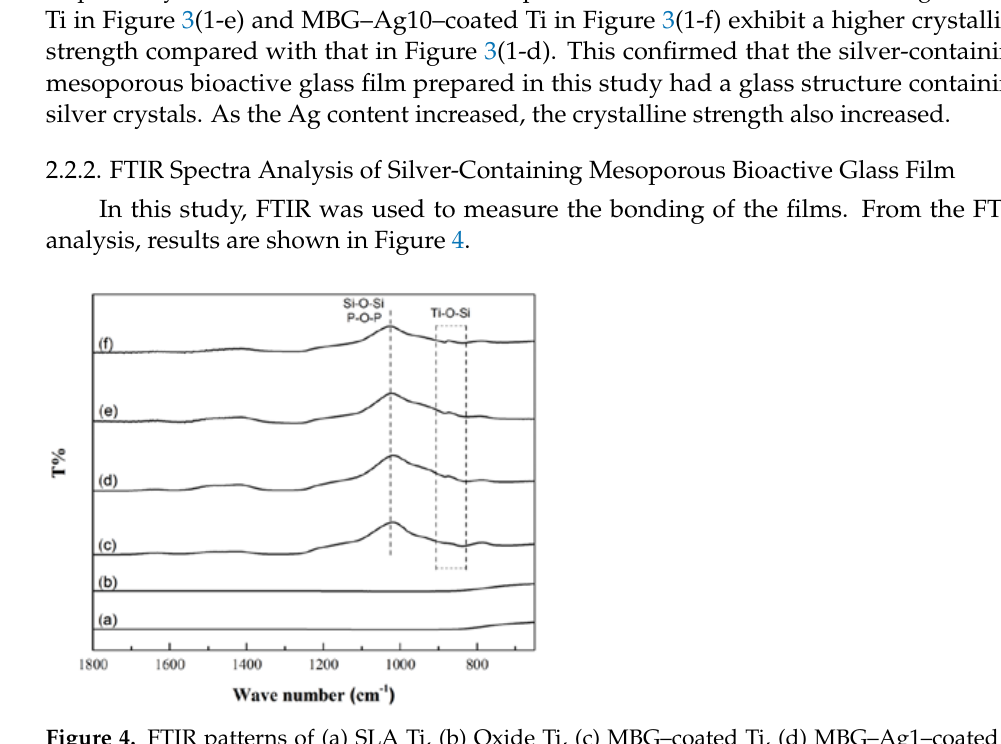
Figure 3. ( 1 ) XRD patterns of (a) SLA Ti, (b) Oxide Ti, (c) MBG–coated Ti, (d) MBG–Ag1–coated Ti,